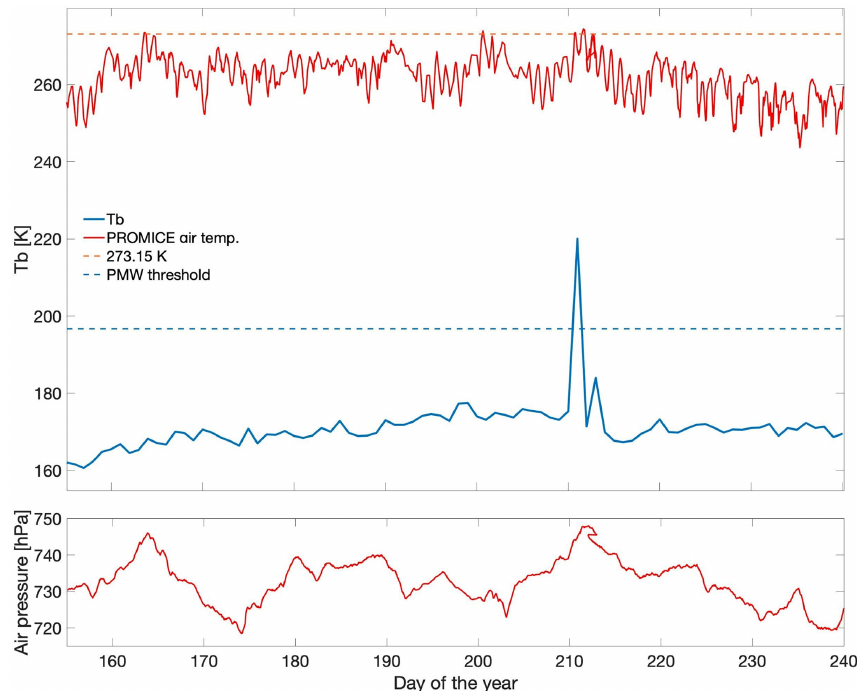
Figure 4. Time series of daily air temperature (top red line) recorded at the EGP PROMICE station (75.6247 ◦ N, 35.9748 ◦ W, 2660ma.s.l.) together with time series of spaceborne brightness temperatures at 19.35GHz recorded over the pixel containing the location of the EGP station (blue line) together with air pressure (hPa) recorded at the same station (bottom red line). The dashed orange line represents the 273.15K values, and the blue dashed line represents the threshold on Tb above which melting is considered to